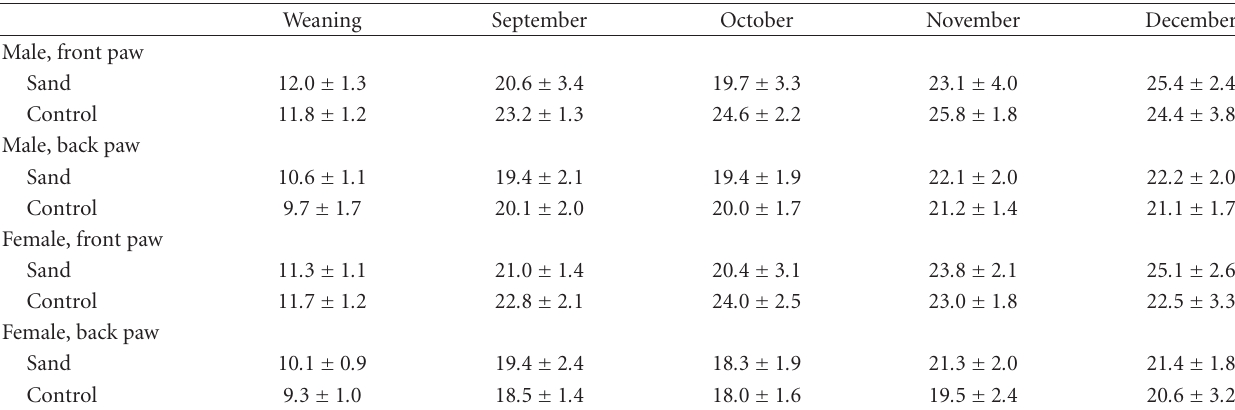
Table 1: Mean claw length (mm, mean ± SD) of front and back right paw at weaning, in September, October, November, and December in juvenile blue foxes in the Sand and Control groups. Main e ff ects (GLM for repeated measures): Group F (1,14) = 0 . 18, NS; Sex F (1,14) = 7 . 60, P = . 015; Month F (4,56) = 206 . 05, P = . 000; Paw F (1,14) = 183 . 74, P = . 000. Interactions: Sex ∗ Group F (1,14) = 3 . 50, P = . 082; Month ∗ Group F (4,56) = 4 . 06, P = . 006; Paw ∗ Group F (1,14) = 20 . 19, P = . 001; Paw ∗ Month F (4,56) = 2 . 94, P = . 028;